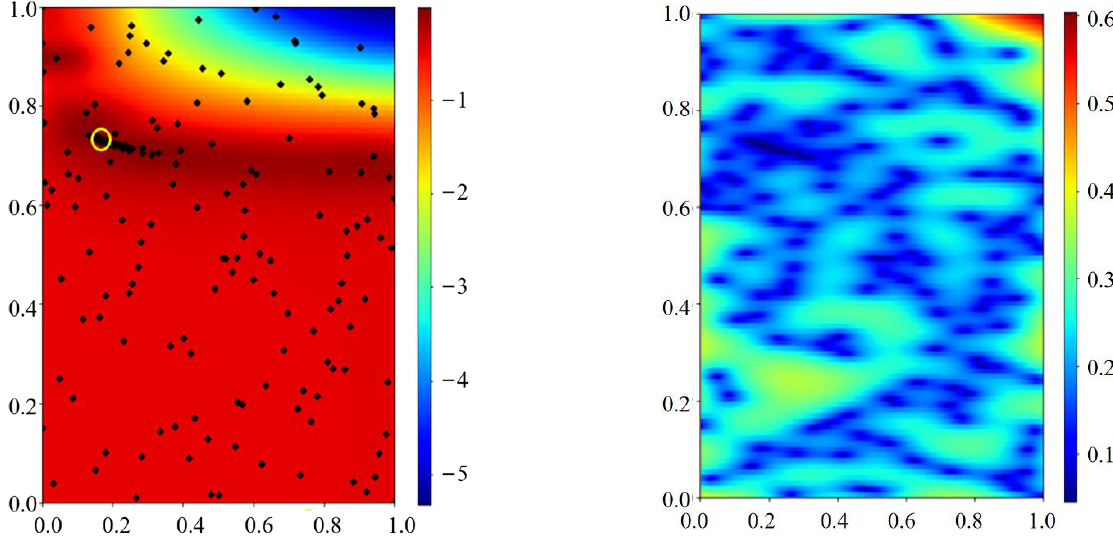
∆ k and n 2 in the Teng